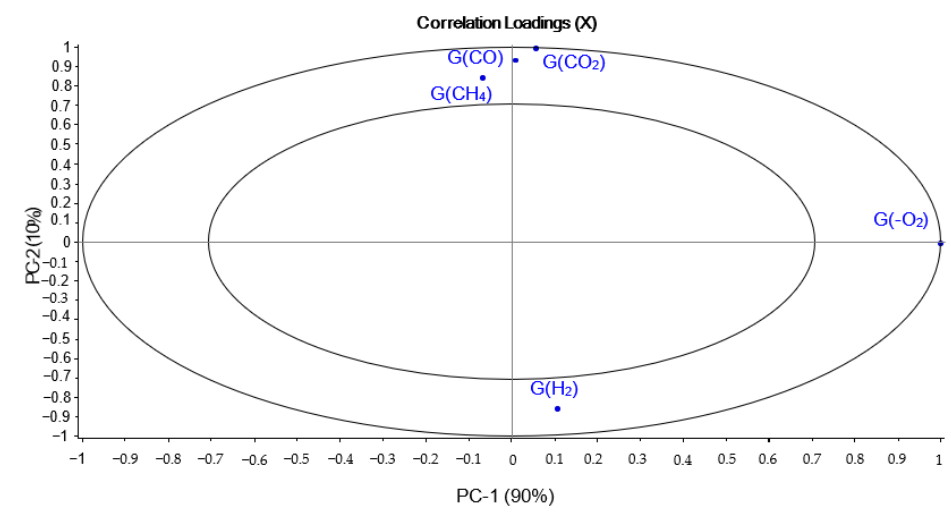
Figure 2. PCA loadings for PC1 and PC2 (Mod1).